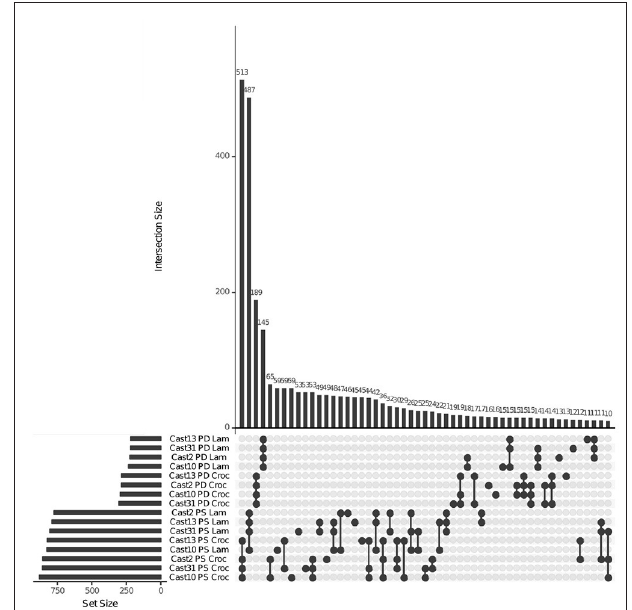
FIGURE 3 | Additive and non-additive expression overlap across T. castellanus individuals. Set IDs represent samples that are additive (A) or non-additive (NA) where parents are different (PD) or the same (PS). Sample sets with common loci are indicated by filled circles with connecting lines, and the number of loci within that intersection may be seen directly above in the bar chart with corresponding size over each bar. The total sample sizes are found in the left bar chart and correspond to the adjacent sample. TABLE 2 | Homoeolog-Specific Expression.